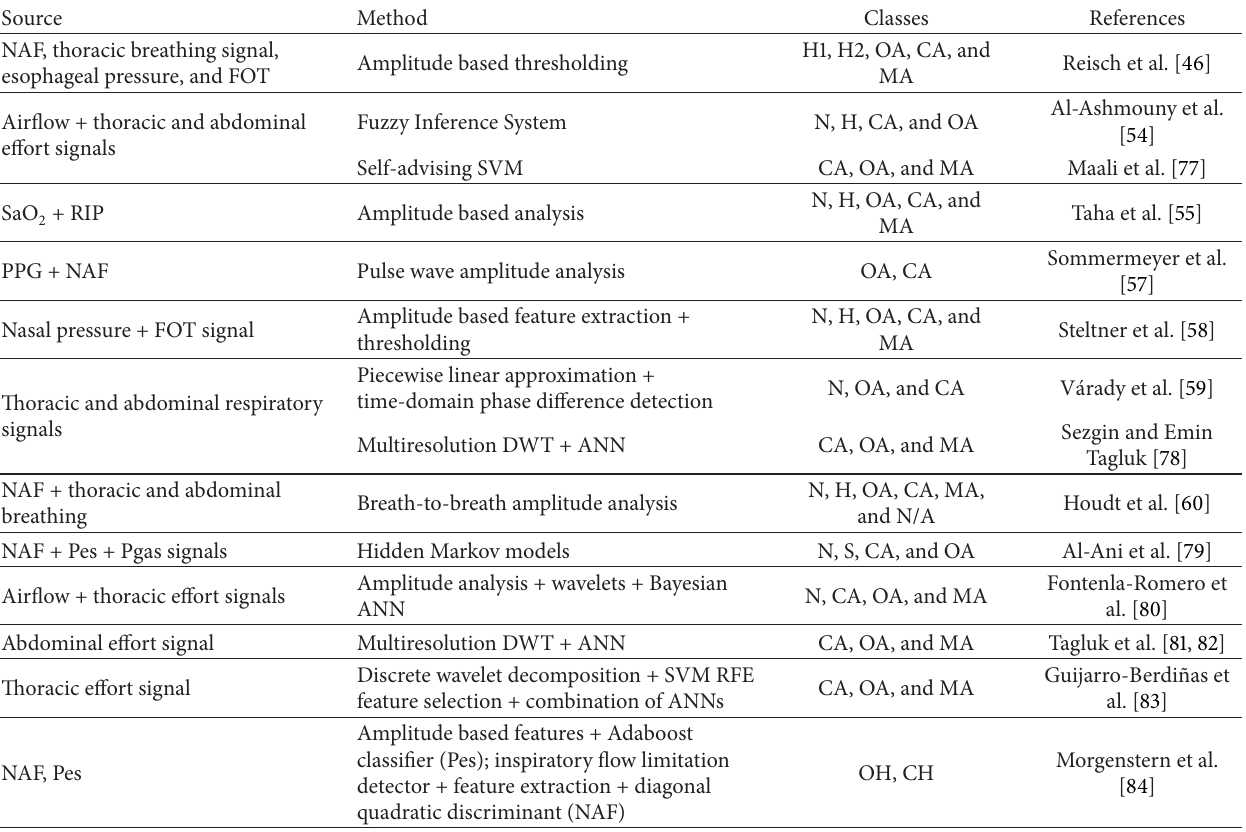
Table 5: Summary of apneic event classification methods. S = snoring; H = hypopnea; N = normal breathing; OH = obstructive